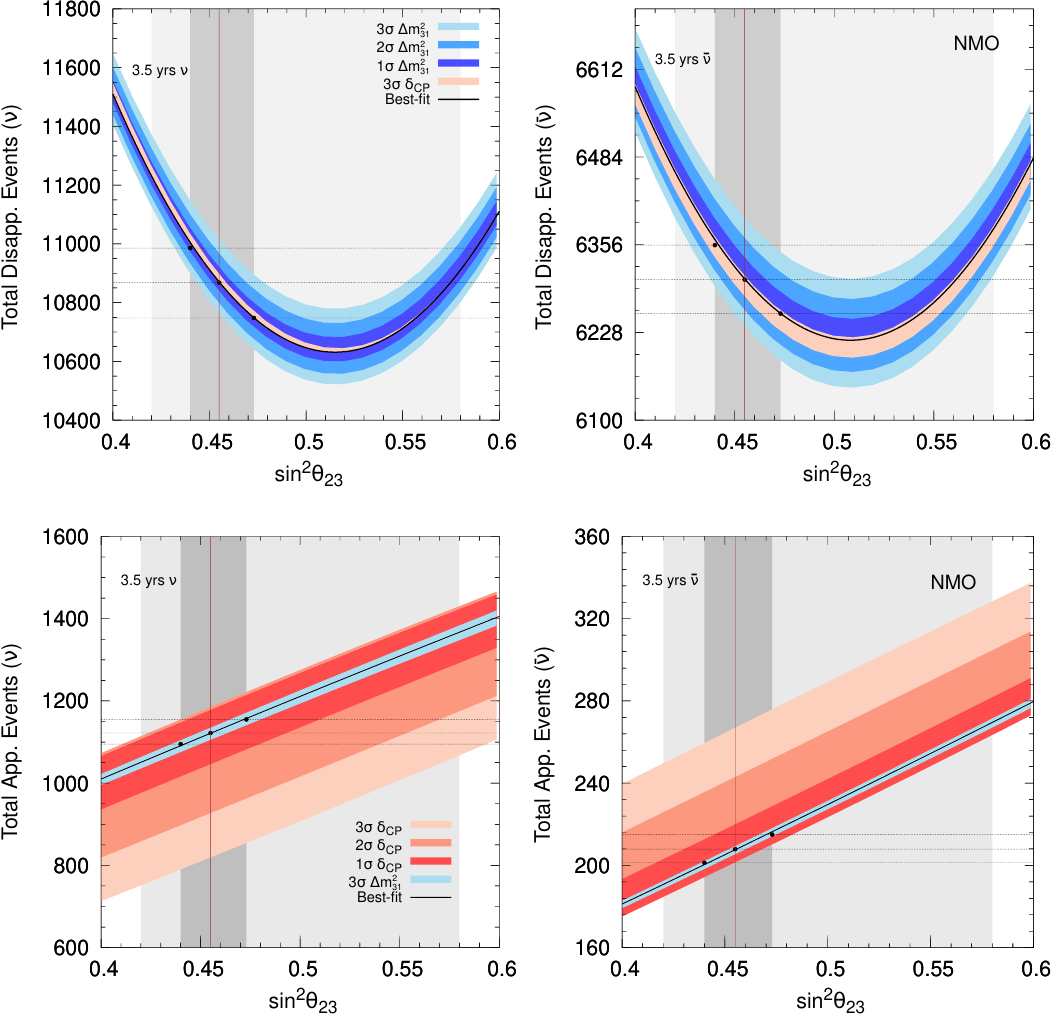
Figure 3 . Total event rates as a function of sin 2 θ 23 for DUNE assuming NMO. The top (bottom) panels are for disappearance (appearance) channel. The left (right) panels are for neutrino (an- tineutrino) assuming 3.5 years of run. The black solid curves show the event rates considering the best-fit values of oscillation parameters as given in table 1. The three shaded blue (red) regions show the variations in events due to present 1 σ, 2 σ, and 3 σ allowed ranges in ∆ m 2 dark (light)-shaded grey area shows the currently allowed 1 σ (2 σ ) region in sin 2 θ value of sin 2 θ = 0 . 455 as shown by the vertical brown line. See table 1 and related text for details. 23 Note that y-ranges are different in all the four